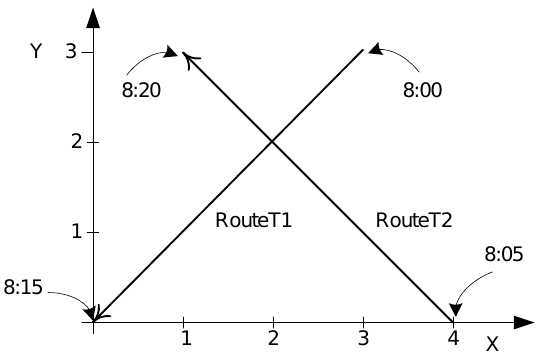
Figure 3. Trajectories of two trucks as a projection of a temporal point into the plane.